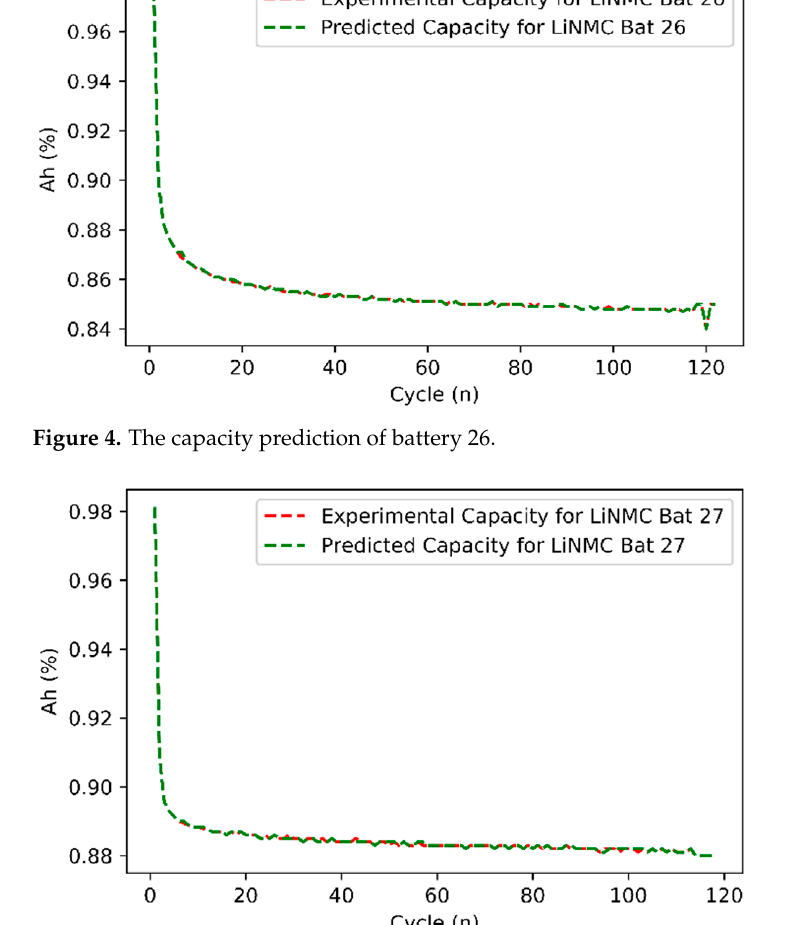
Figure 5. The capacity prediction of battery 27.